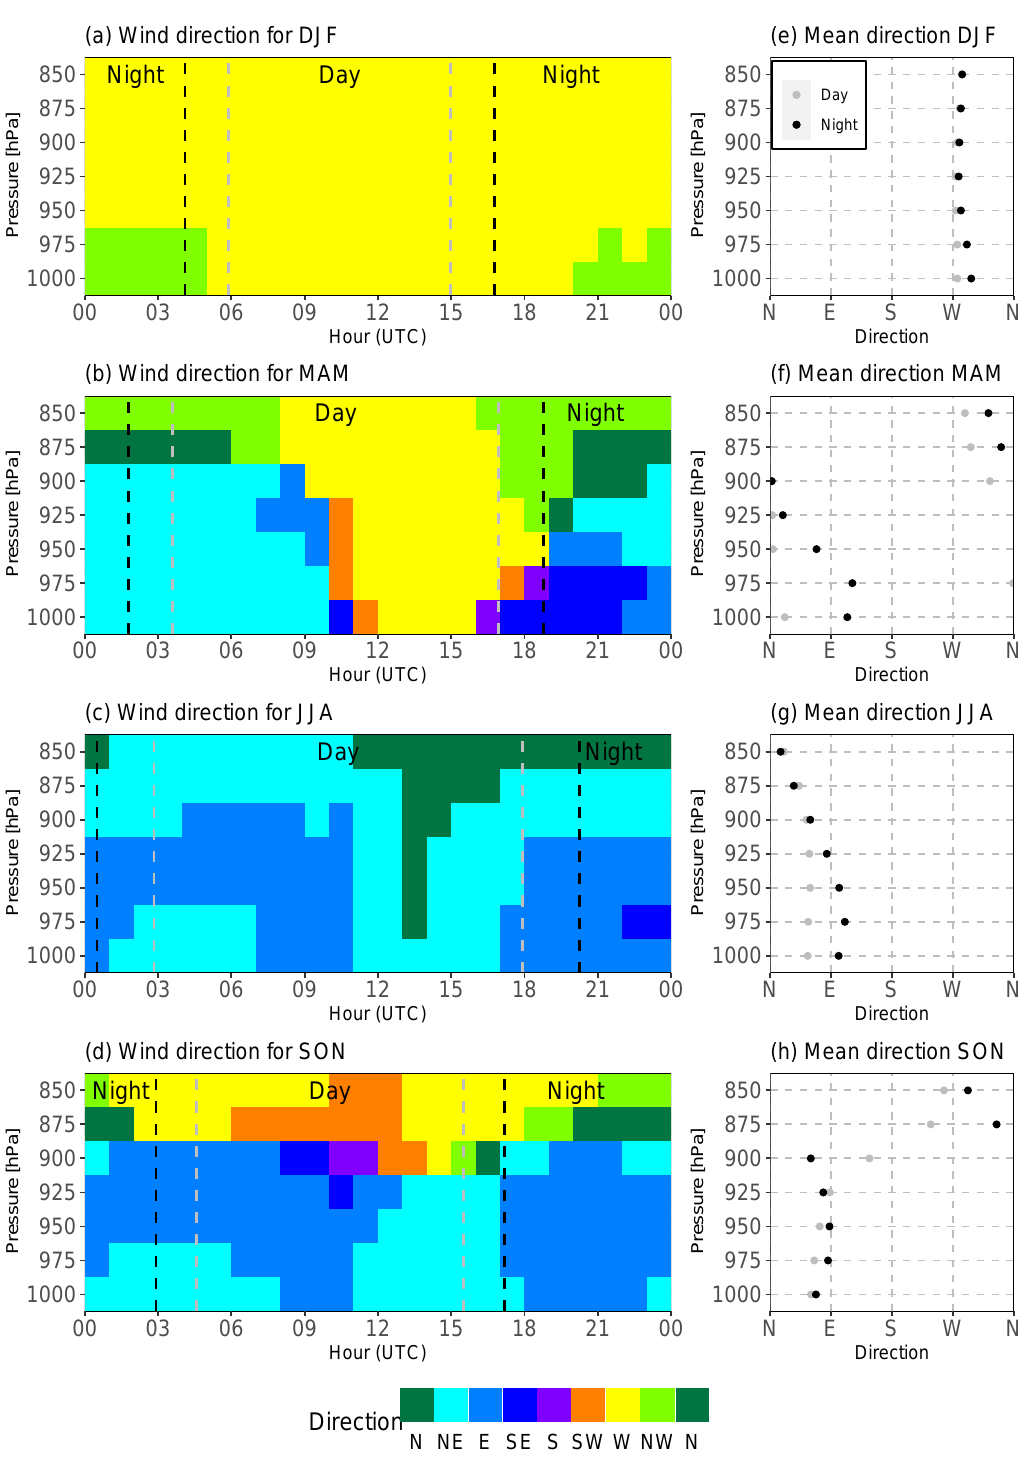
Figure 9. ERA5 hourly means of horizontal wind directions for December 2019–November 2021 analysed period for all seasons ( a – b ) and the mean direction profiles for daytime and nighttime ( e – h